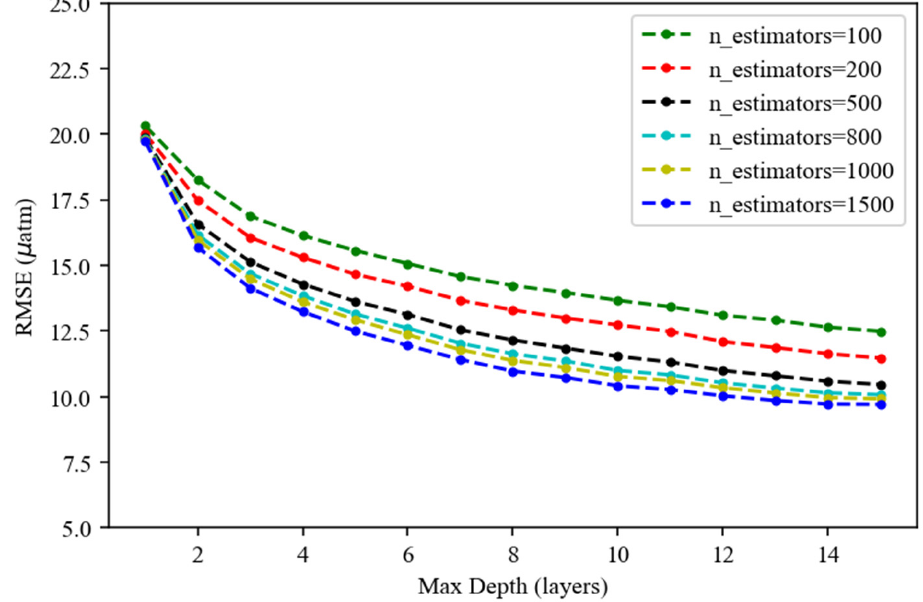
Figure 2. The performance of the CatBoost model in model validation in different max-depths and a different number of estimators.